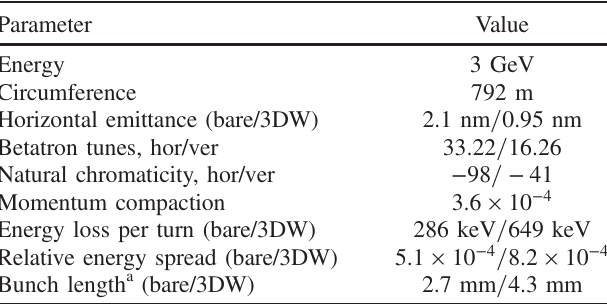
TABLE I. NSLS-II storage ring.